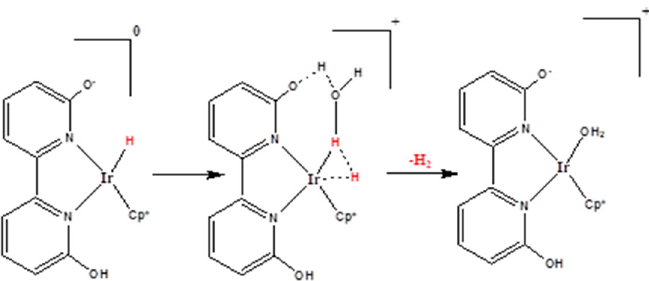
Figure 8. Effect of the pH-tunable ligand in the FA dehydrogenation reaction. Figure adapted from Reference [56].